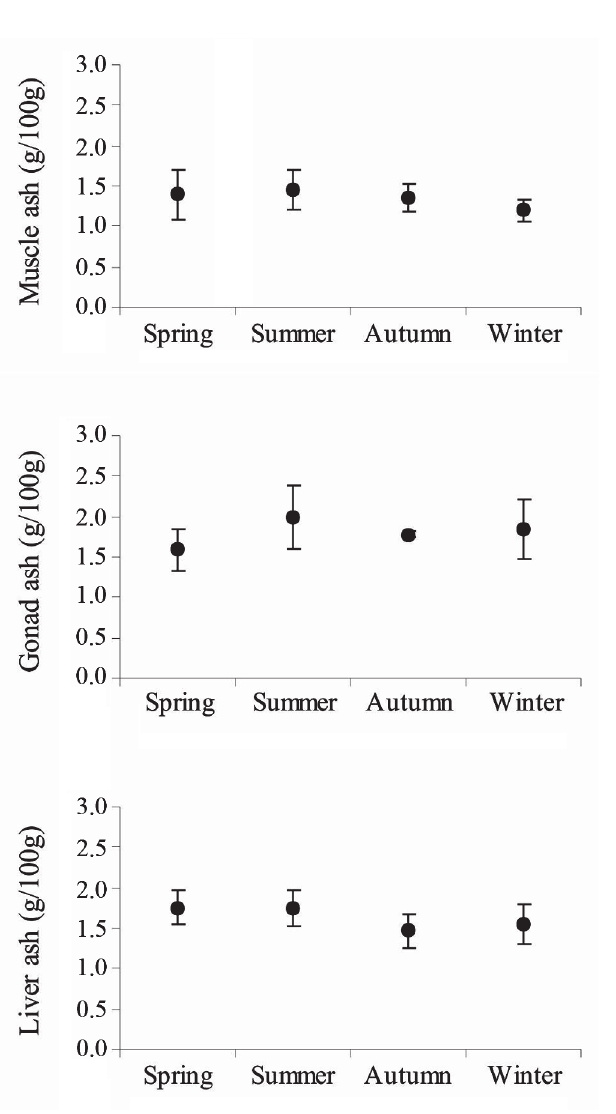
Fig. 6. Seasonal variation of energy density in muscle, gonad and liver of Percophis brasiliensis